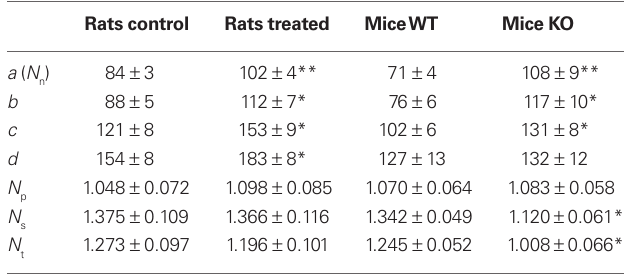
Table 1 | Summary of the data obtained for the four groups in experiments 1 and